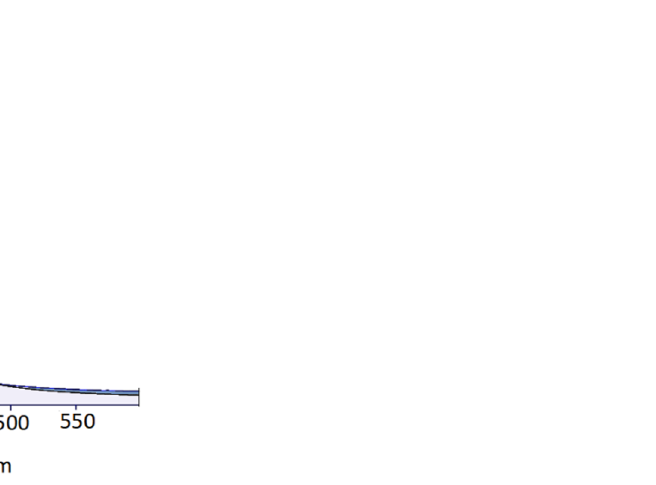
Figure 1. UV–vis absorption spectra of Ag colloids without ( A ) and with ( B ) the presence of piperidine.